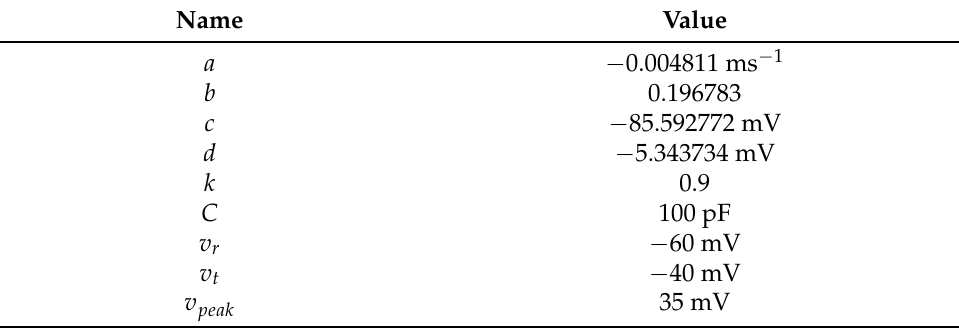
Table 3. Values of a, b, c, d and k for sigmoidal response.